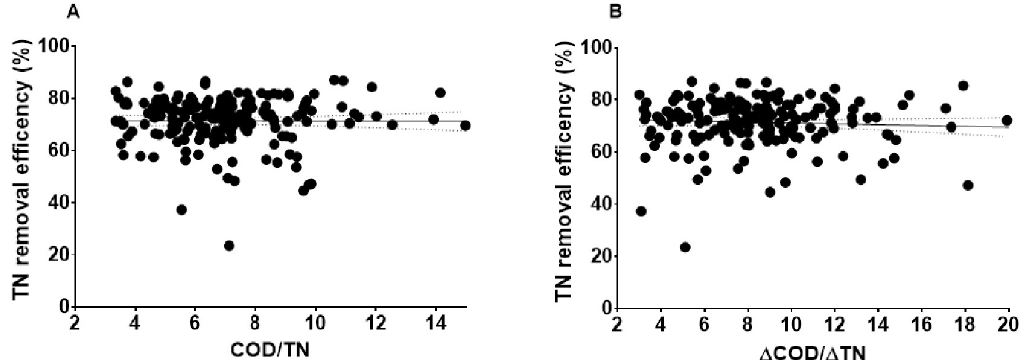
Fig 1. The relationship of COD/TN (A) and Δ COD/ Δ TN (B) with TN removal efficiency.